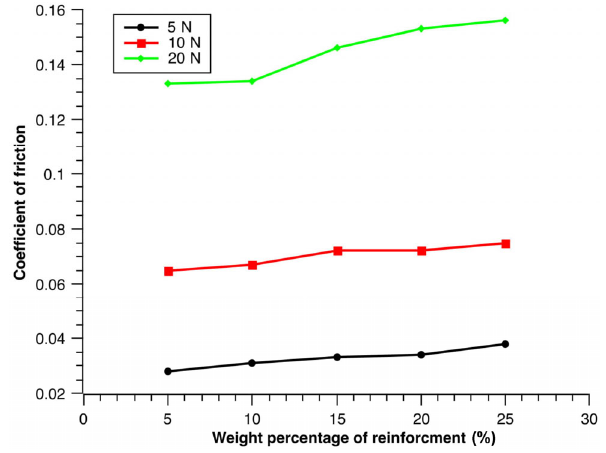
Fig. 3 Coefficient of friction at varying loads.